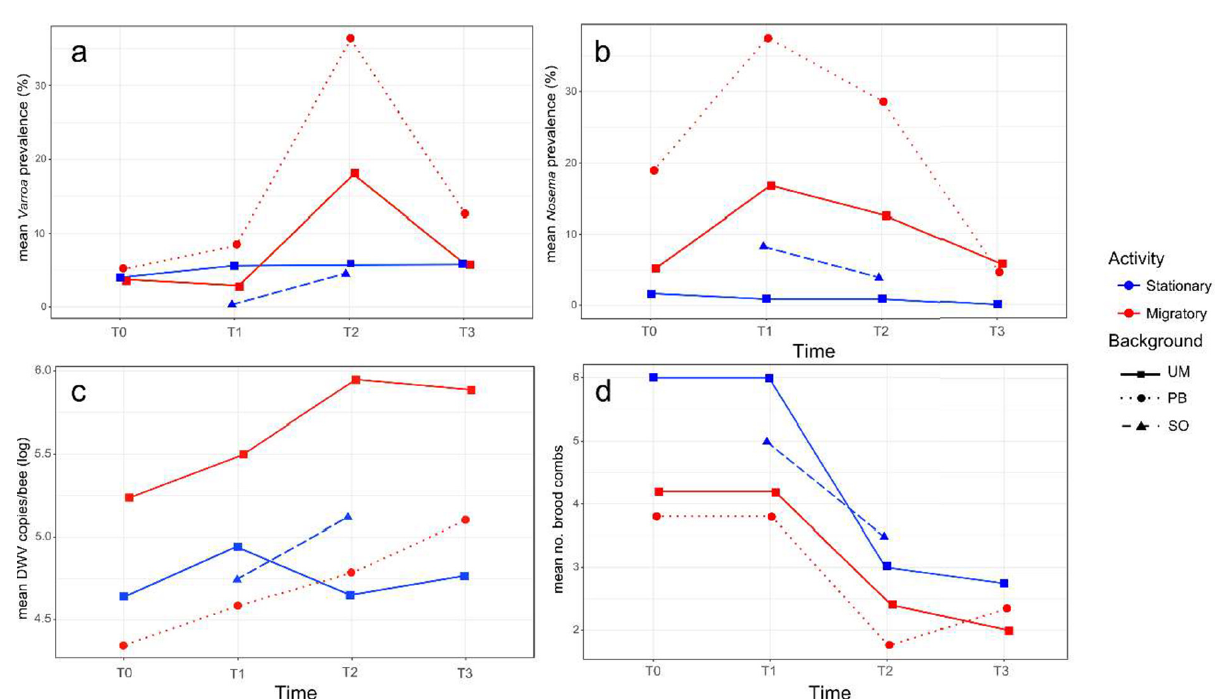
Figure 2. Average data per colony group (stationary in blue and migratory in red), genetic background (squares for the University of Murcia (UM), circles for the professional beekeeper (PB) and triangles for Soria (SO)) and sampling time (T 0 , T 1 , T 2 and T 3 ) of the variables: ( a ) infestation rate of V. destructor ; ( b ) infestation rate of N. ceranae ; ( c ) log10 DWV copy number/bee; ( d ) number of brood combs.